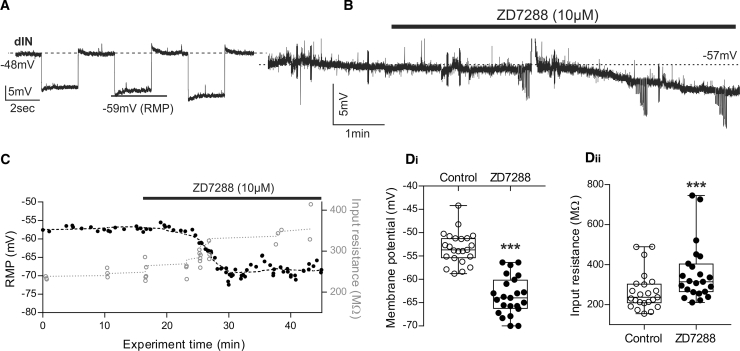
Ih Current Is Active at Rest and Contributes to the Intrinsic Properties of dINs(A) When dINs were held depolarized (∼−48 mV), hyperpolarizing pulses revealed a sag response around the original RMP.(B) Raw trace on a slow time base showing a clear membrane hyperpolarization of approximately 10 mV following the application of ZD7288 (10 μM). Blockade of Ih hyperpolarized all dINs.(C) Resting membrane potential (RMP) and input resistance plotted against experiment time for the experiment shown in (B). The hyperpolarization was accompanied by an increase in input resistance. Dashed line indicates the change of IR of the dIN in (B).(D) Pooled paired data showing that (Di) the membrane potential of dINs was significant hyperpolarized by ZD7288 (n = 23; p < 0.001; median with 50% IQR displayed as box-and-whisker plots). (Dii) Pooled paired data show a significant increase in input resistance in ZD7288 (n = 23; p < 0.001; median with 50% IQR displayed as box-and-whisker plots). ∗∗∗p < 0.001. See also Figure S2.